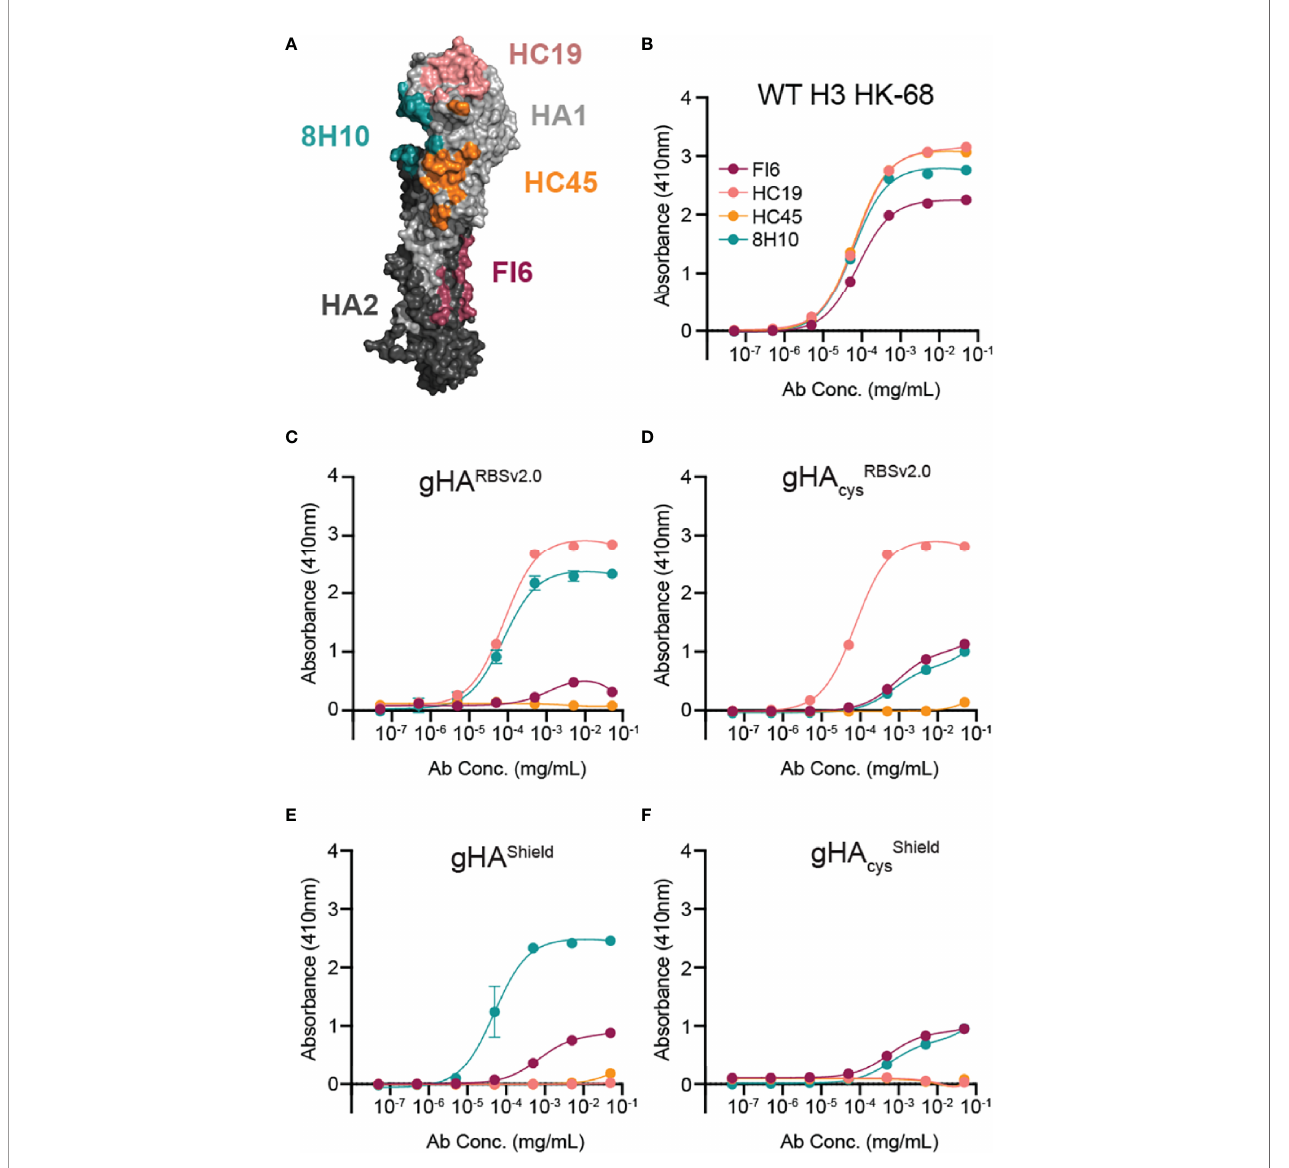
FIGURE 2 | Characterization of gHA immunogens with structurally characterized antibody panel. (A) Antibody panel epitopes mapped onto WT H3 HK-68 monomer (PDB: 4WE4). Antibodies are representative of four major antigenic sites on HA: HC19 (pink; PDB: 2VIR; receptor binding site (RBS)), HC45 (orange; PDB: 1QFU; vestigial esterase domain), FI6 (maroon; PDB: 3ZTJ; stem), and 8H10 (teal; PDB: 6N5B; interface). (B – F) Selective placement of glycans and interface cysteines on gHA immunogens abrogate binding of epitope-speci fi c antibodies as shown by ELISA. Binding curves of the antibody panel are shown against WT H3 HK-68 (B) , gHA RBSv2.0 (C) , gHA cysRBSv2.0 (D) , gHA Shield (E) , gHA cysshield (F) . Average absorbance at 410nm ± SD is reported for technical